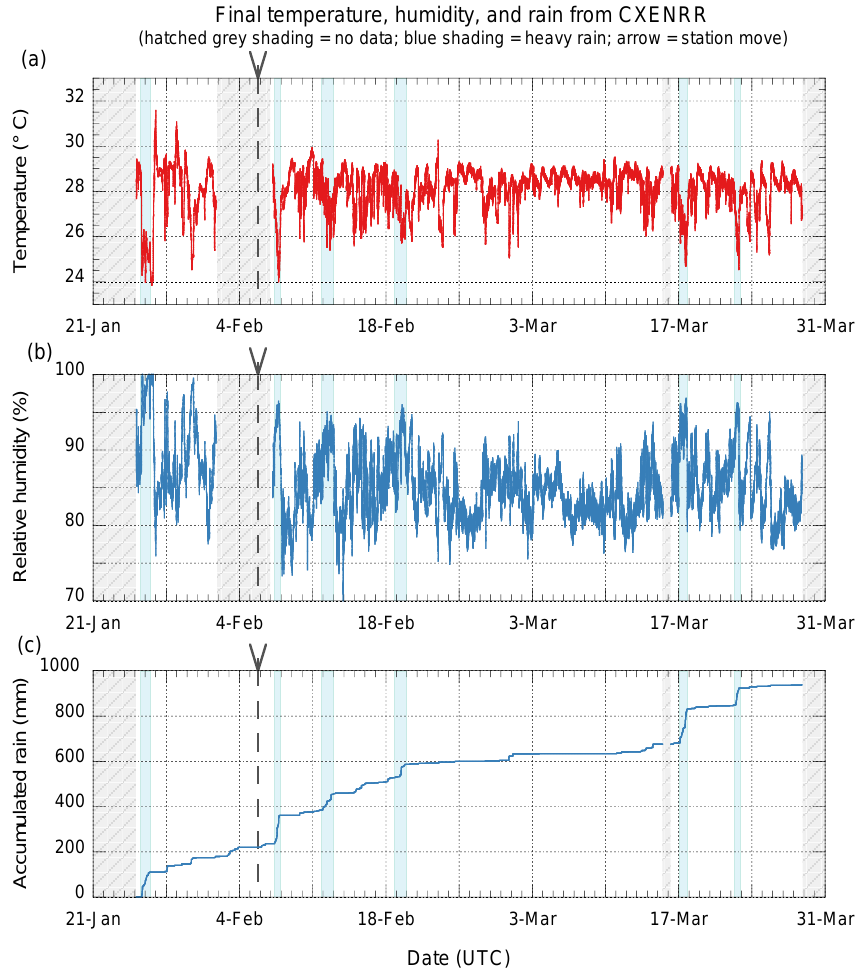
Figure 8. The final time series of temperature (a) and relative humidity (b) from Kiritimati Island, together with the accumulated rain- fall (c) during the deployment. Pale blue shading indicates the six largest rainfall events, and is repeated on all graphs for reference, while hatched grey shading indicates times with no